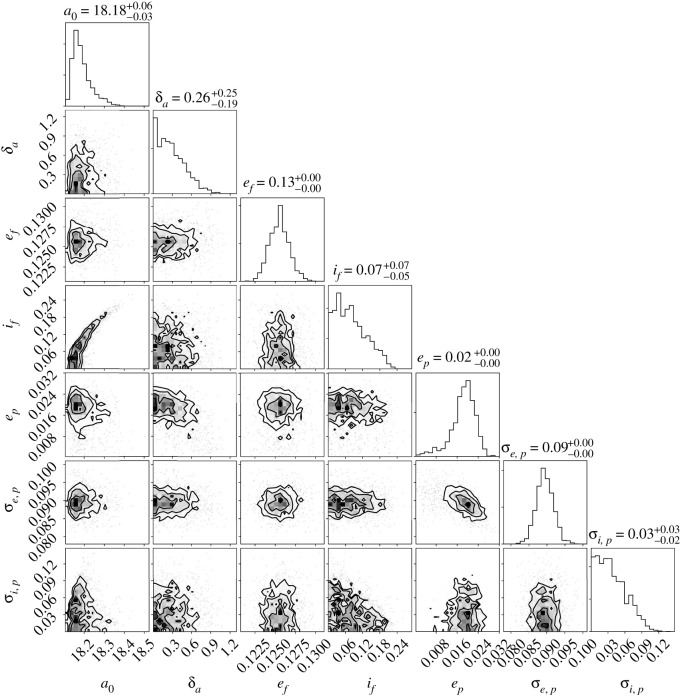
Posterior parameter distributions for the full model of the Fomalhaut ring with a uniform distribution of semi-major axes. Only parameters related to the eccentric disc model are shown here. Each off-diagonal panel shows the two-dimensional distributions, with 1, 2 and 3σ contours in regions of high density, and individual dots in regions of low density. The diagonal panels show the one-dimensional distributions.